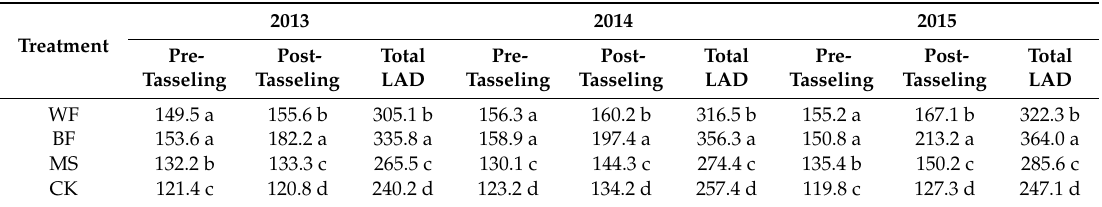
Table 5. LAD (m 2 m − 2 d) of maize at di ff erent growth stages under di ff erent treatments in 2013, 2014, and